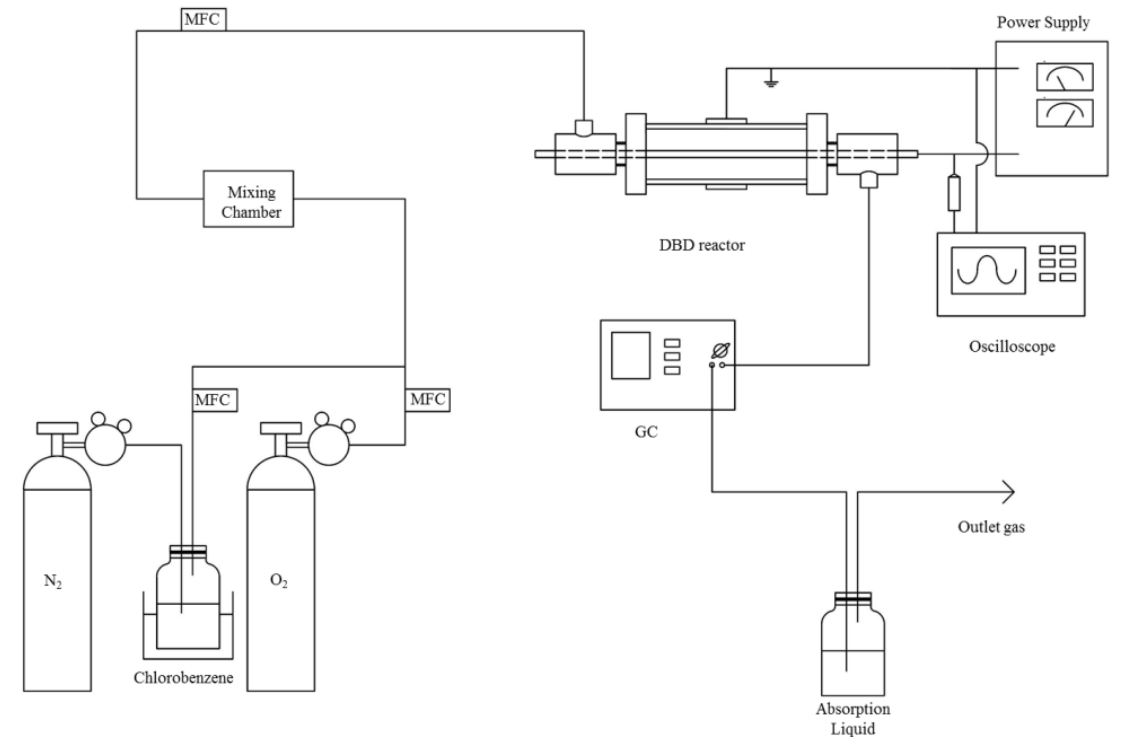
Figure 1. Schematic diagram of the experimental setup (outlet).